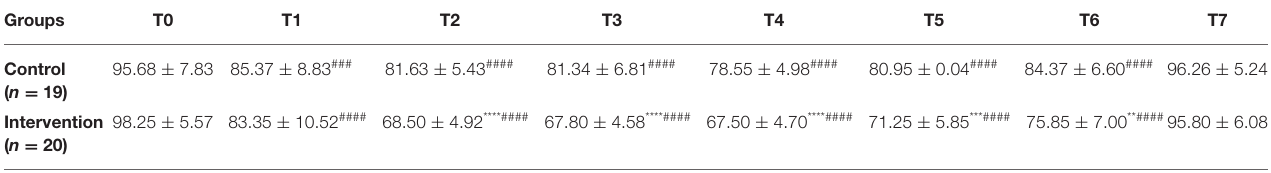
TABLE 3 | Comparison of MAP (mmHg) at each time point between control and intervention groups. Groups